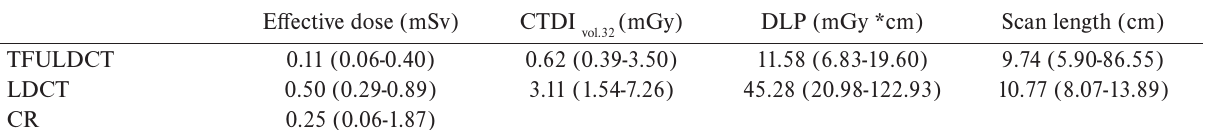
Table 3. Doses for each method.